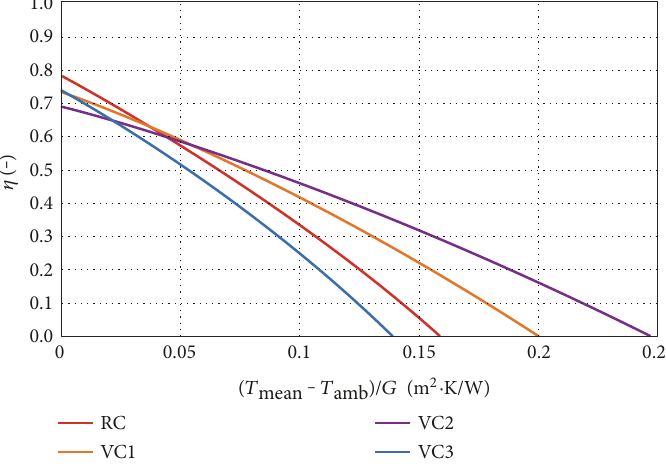
Figure 8: E ffi ciency characteristics of di ff erent solar collector